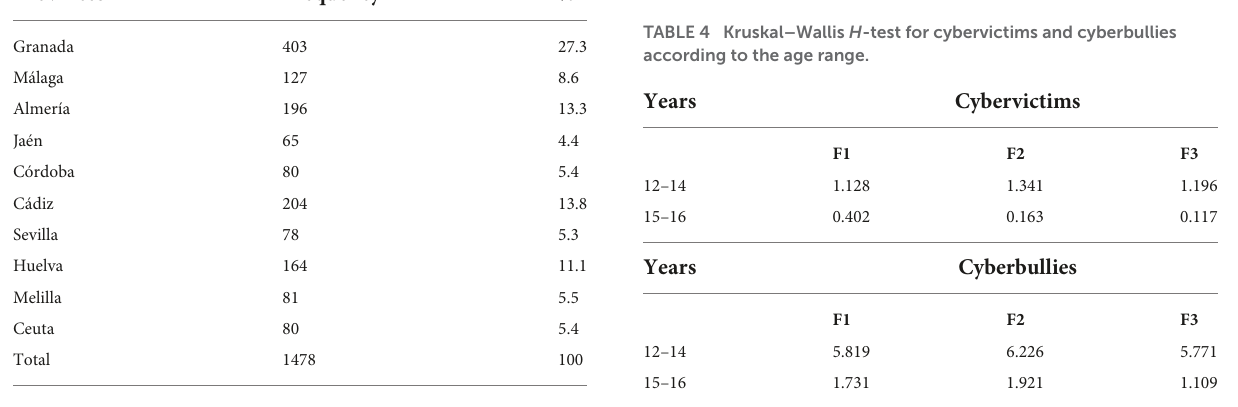
TABLE 1 Distribution of participants according to the province. Provinces